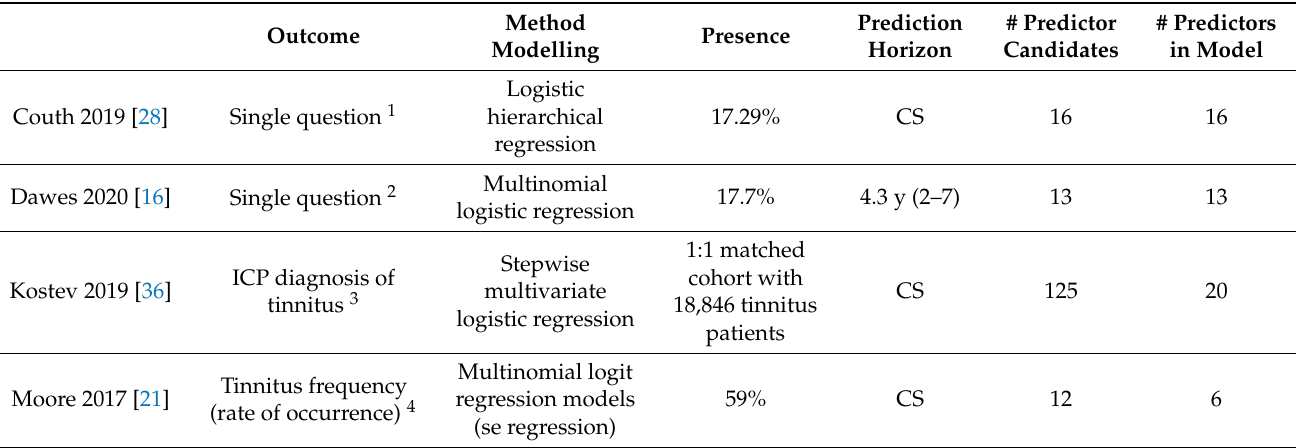
Table 6. Studies with tinnitus presence as an